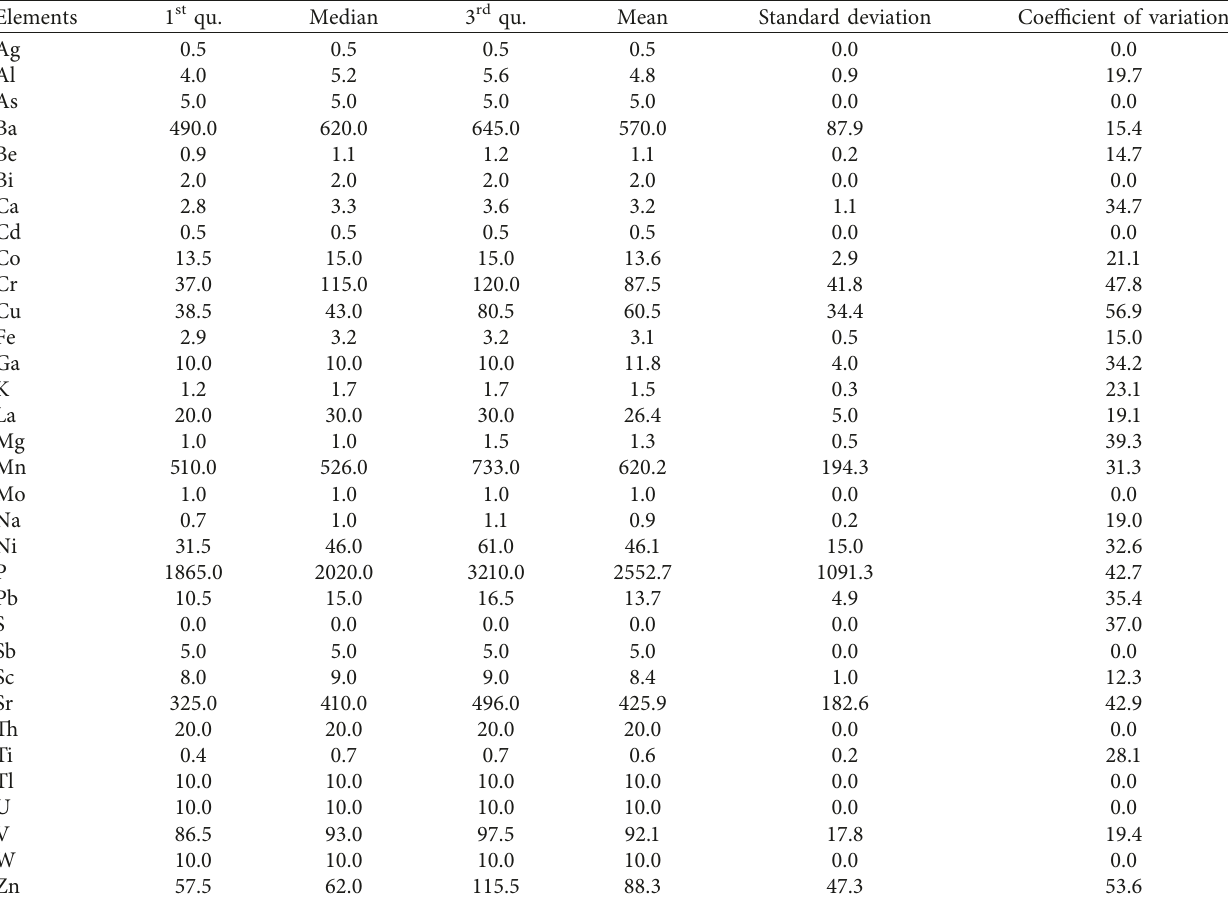
Table 4: Summary statistics for the concentration of different chemical elements within midden deposits.